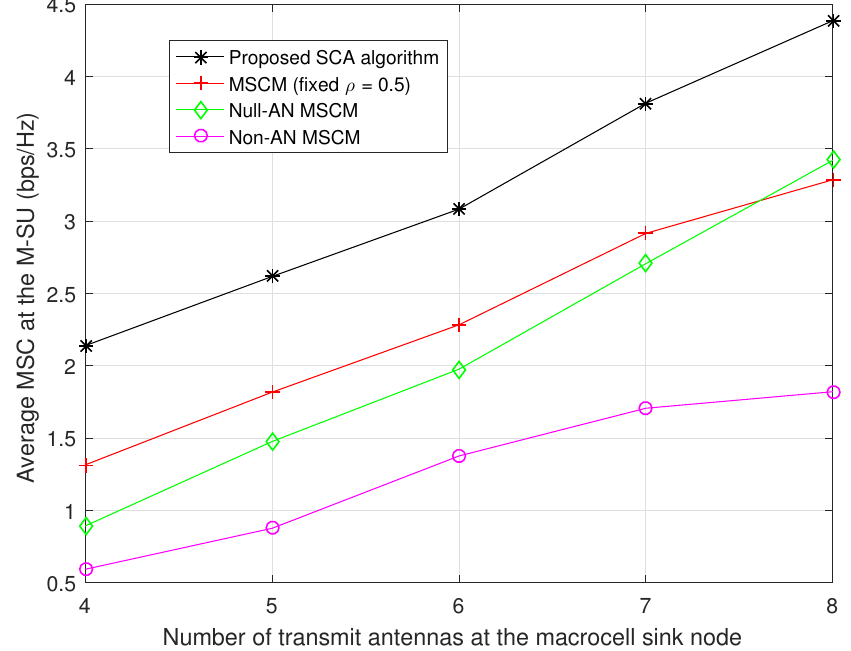
Figure 6. Average MSC at the M-SN with respect to the number of transmit antennas at the macrocell sink